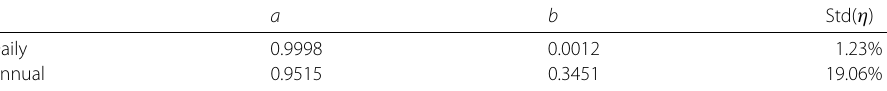
Table 4 Coefficients of the exponential Ornstein–Uhlenbeck process obtained for the gold spot price through the least squares method a b Std( η ) Daily 0.9998 0.0012